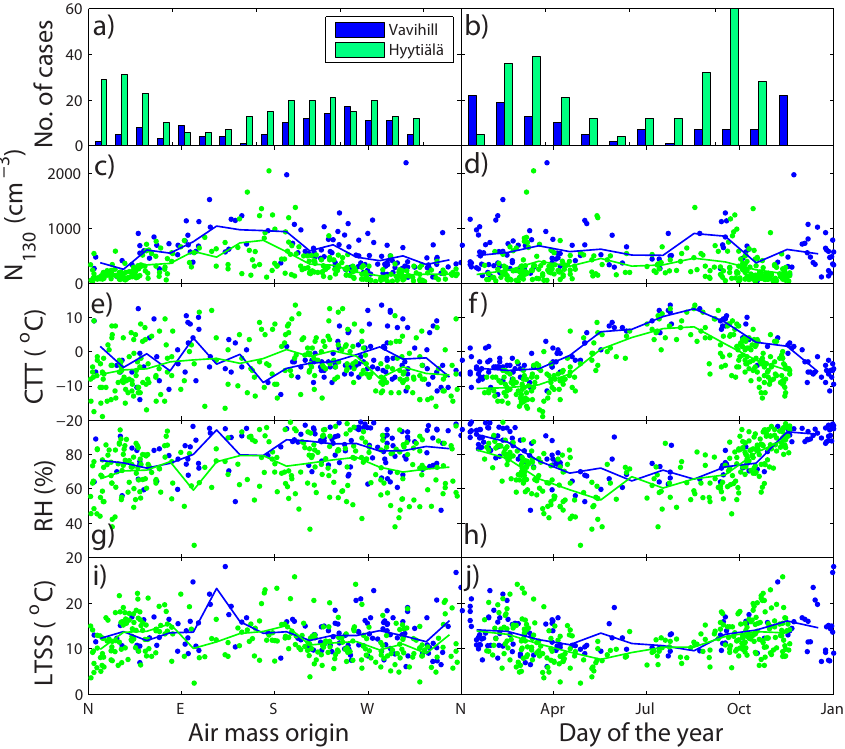
Figure 2. Number of cases, number concentration of aerosol particles with a diameter larger than 130nm (N 130 ) , cloud top temperature (CTT), relative humidity at 1000hPa (RH) and low tropospheric static stability (LTSS) plotted against air mass origin (a, c, e, g, i) and day of the year (b, d, f, h, j) for Vavihill (blue dots) and Hyytiälä (green dots). The lines in the figures are mean values over 22.5 ◦ (a, c, e, g, i) and over 30 days (b, d, f, h, j) . Table 4. Linear correlation coefficients for the data set from Vavihill (top right) and logarithmic correlation coefficients (bottom left). The logarithm has not been applied to the CTT and dbcz parameters since these contain mainly negative values. The stars indicate at what confidence level ( ∗ is 95%, ∗∗ is 99%, and ∗∗∗ is 99.9%) the correlation coefficients are significant. N 130 (cm − 3 ) is the number of particles with a diameter above 130nm, CTT ( ◦ C) is the cloud top temperature, RH (%) is the relative humidity, SH (gkg − 1 ) is the specific humidity, LTSS ( ◦ C) is the low tropospheric static stability, dbzc (dBZ) is mean radar reflectivity factor and only cases defined as precipitating are included, r e (µm) is the effective radius, COT is the cloud optical thickness, and LWP (gm − 2 ) is the liquid water path. N